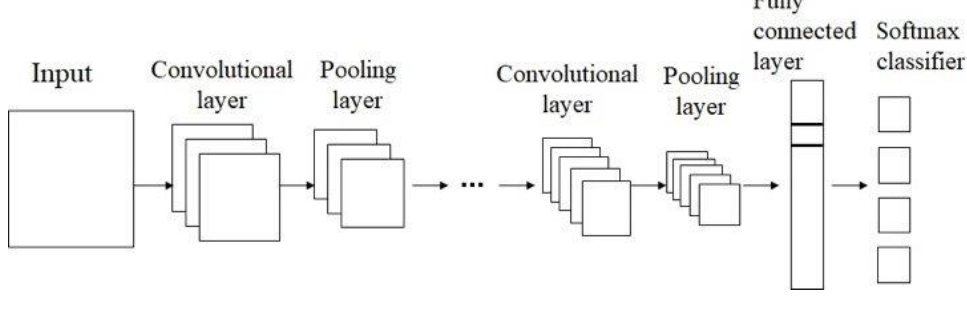
Figure 4. The Structure of CNN